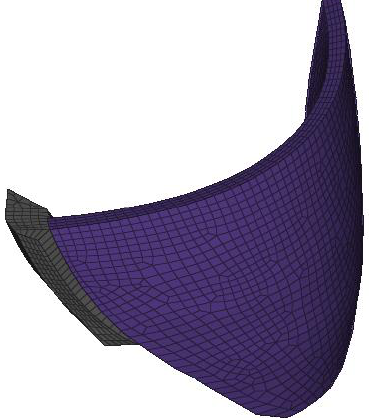
Figure 17. The finite element model of dam and the left-bank cushion.